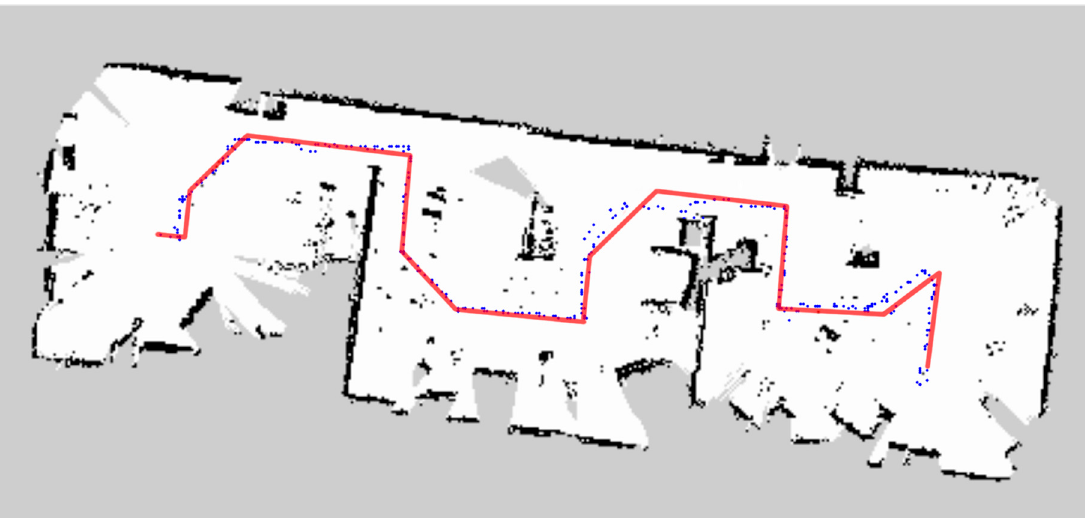
Figure 15. Planned and ideal path in the office room.